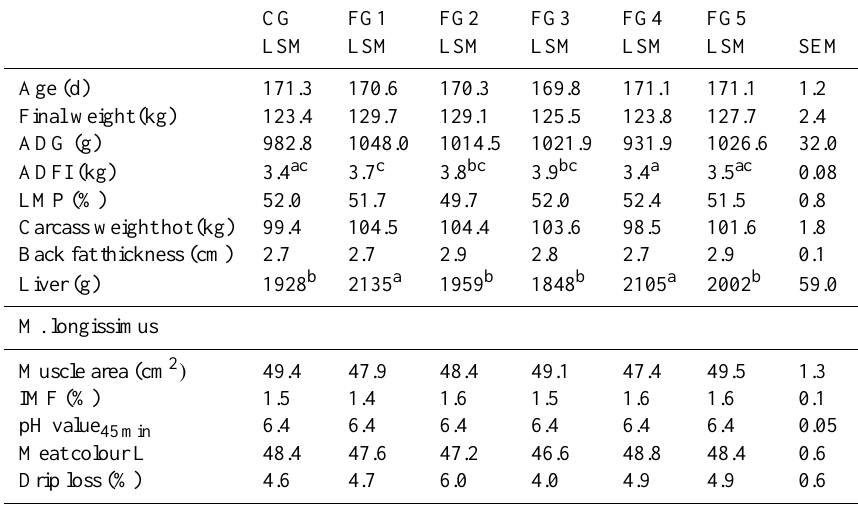
Table 4. Growth performance, carcass traits and meat quality of pigs fed diets supplemented with sea buckthorn pomace.